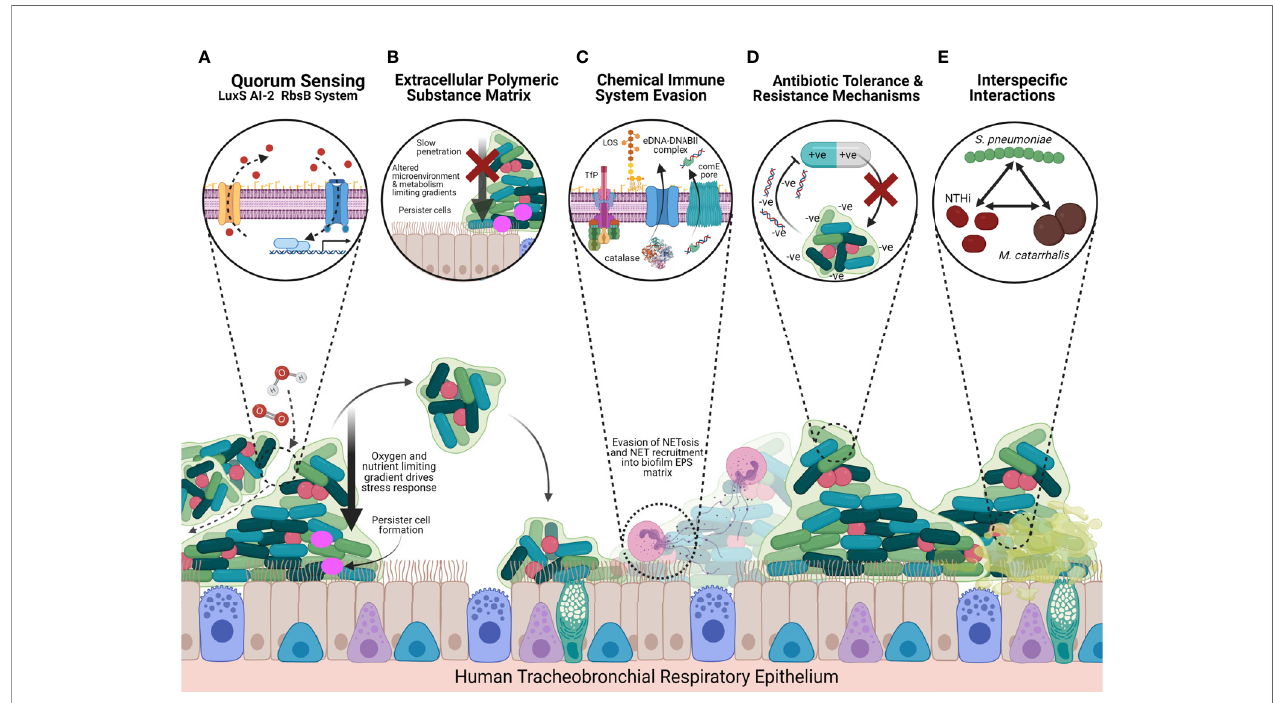
FIGURE 2 | Model of NTHi Bio fi lm Strategies and Host-Pathogen Interactions Facilitating Chronic Infection in the COPD Airways. (A) The LuxS-RbsB AI-2 quorum sensing system facilitates coordination of intra-speci fi c and inter-speci fi c gene expression that promotes a transition from the planktonic to bio fi lm lifestyle in response to the local environmental conditions, leading to the downstream transcription of bio fi lm-associate genes. NTHi also express a QSeB two-component secondary system that may support bio fi lm gene expression coordination where the LuxS-RbsB system has been impaired. The quorum sensing system drives dissemination of bio fi lm bacteria to secondary sites, and formation of oxygen, nutrient and water channels towards the centre of the bio fi lm. (B) NTHi bio fi lms produce a thick protein- and eDNA-rich EPS matrix that provides a physical and chemical barrier, slowing penetration against pharmacological and immune system antimicrobial agents by blocking phagocytes and macrophages and chelating peptides and antibiotics such as b -defensin and b -lactams. The EPS matrix also provides structural stability and provides a site for mature bio fi lm structures to form, whilst also limiting metabolic activity, altering microenvironments, and driving persister cells through the development of gradients towards the centre of the bio fi lm. (C) NTHi express chemical defence strategies that allow for the evasion of the host ’ s NETosis response through recruitment of NETs into the EPS and expression of catalase that provides oxidative stress tolerance. Recognition by the immune system is also modulated through the differential expression of LOS and OMP P5 and OMP P2 that recruit neutrophils to form NETs but by evading the phagocytosing and cytotoxic mechanisms. NTHi bio fi lms further undergo a series of surface modi fi cations that promote irreversible attachment, recruit secondary colonisers and impair recognition and/or clearance by immune system factors. These include sialyation, phosphorycholination, and the expression of TfP, OMPs and HMWs. (D) NTHi bio fi lms exhibit multidrug resistance due to upregulated carbohydrate metabolism and a preference for glycogen metabolism, as well as expressing antibiotic resistance genes including penicillin-binding protein 3 (PBP3) and b -lactamases. Negatively charged eDNA in the EPS matrix also sequesters positively charged antimicrobials. (E) Bio fi lms are seldom mono-species and exhibit complex inter-speci fi c interactions with other inhabitants of the microbiome. In particular NTHi interacts with other COPD-associated pathogens including S. pneumoniae and M. catarrhalis that selects for hypoxia tolerant NTHi and damages cilia and mucociliary clearance, respectively, favouring NTHi bio fi lm formation. Tissue shown is the tracheobronchial respiratory mucosa, a pseudostrati fi ed, ciliated, columnar epithelium predominated by ciliated epithelial cells and interspersed by secretory cells (mucus-secreting goblet cells and secretoglobin secreting club cells) and basal cells. Created with